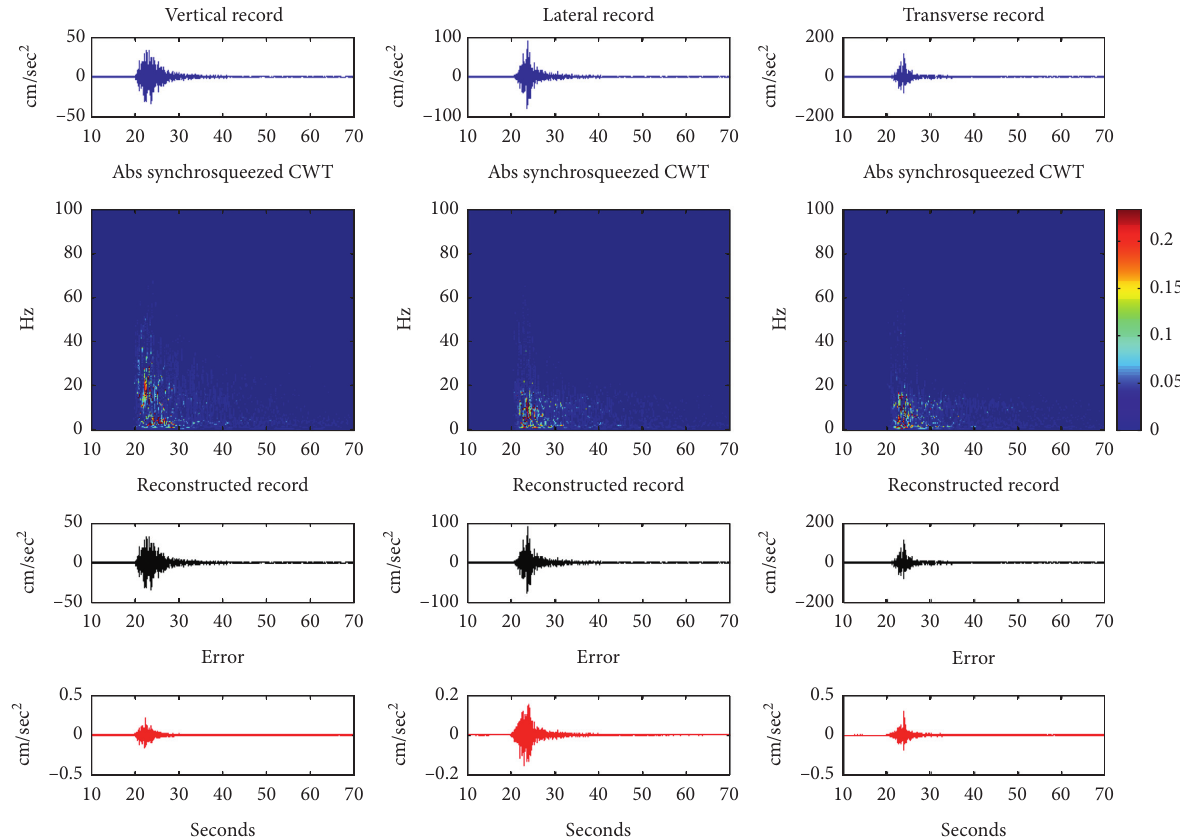
Figure 8: Synchrosqueezing CWT analysis of the Mosha 2020 earthquake accelerograms recorded in Mosha3